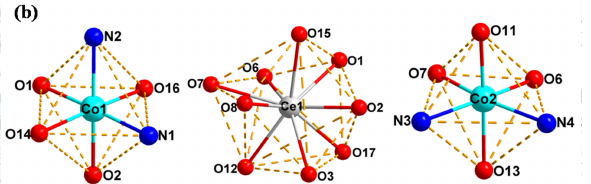
Figure 4. ( a ) View of the molecular structure of the Co(II)-Ce(III) complex; ( b ) Coordination polyhedrons for Co(II) and Ce(III) atoms.